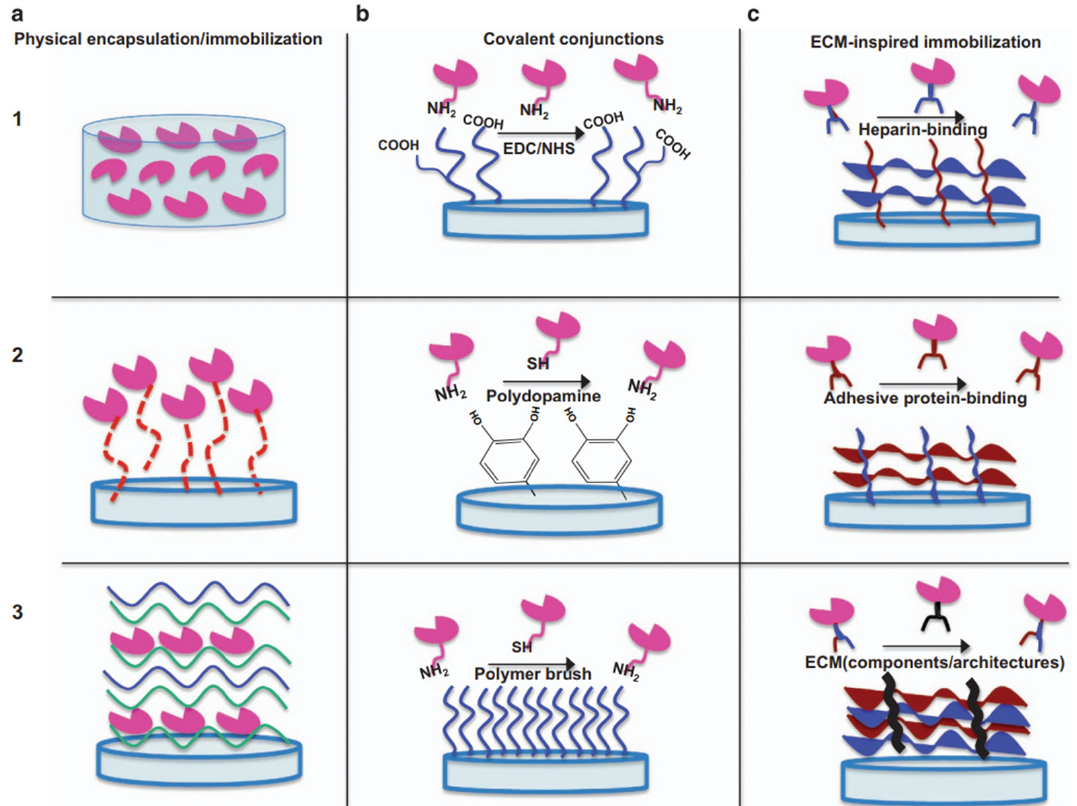
Figure 3. Approaches for the immobilization/encapsulation of growth factors (GFs) to biomaterials. ( a1–a3 ) Physical immobilization techniques. ( b1–b3 ) Non-selective covalent immobilization of GFs ( a1 – a3 ) Physical immobilization techniques. ( b1 – b3 ) Non-selective covalent immobilization of GFs through their functional residues. ( c1–c3 ) Extracellular matrix (ECM)-inspired immobilization through their functional residues. ( c1 – c3 ) Extracellular matrix (ECM)-inspired immobilization reactions used for the orientation of GFs on the surfaces of biomaterials. Reprinted from [91],